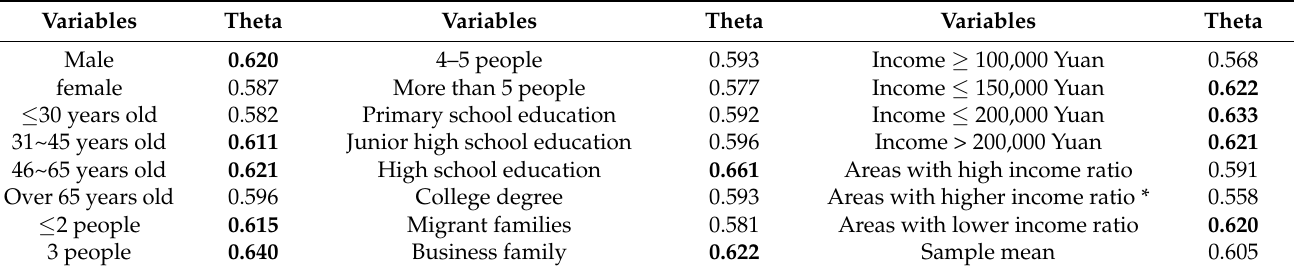
Table 4. Analysis on the characteristics of rural households’ common